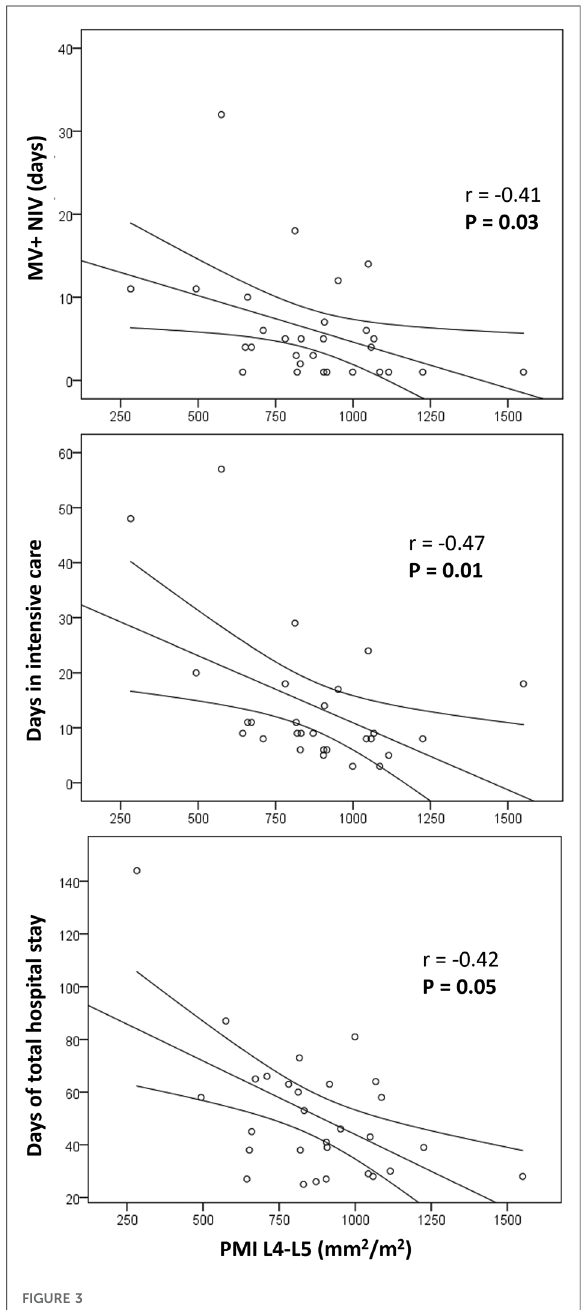
FIGURE 3 Correlation of psoas muscle mass with post-transplantation variables. There was a negative correlation between psoas muscle index (PMI) and the days of ventilation, both mechanical ventilation and non-invasive ventilation. There was also a negative correlation between PMI and days in ICU and total hospital